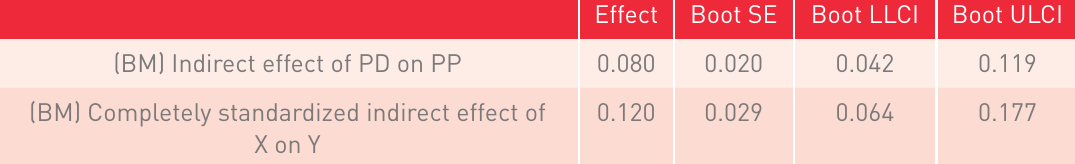
Effect Boot SE Boot LLCI Boot ULCI